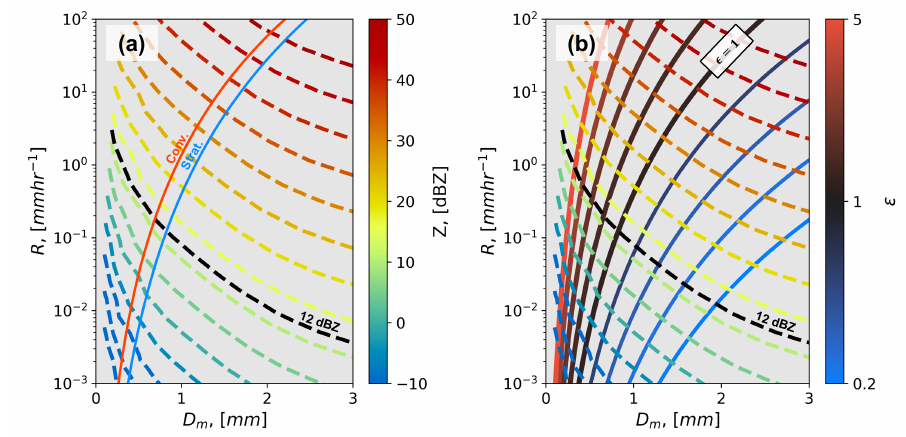
Figure 2. Precipitation rate ( R ) and mass weighted mean diameter ( D m ) theoretical diagrams. ( a ) The default ( (cid:101) = 1) R − D m relation for both convective (solid red line) and stratiform (solid blue line) regimes with the equivalent radar reflectivity factor ( Z e ) in logarithmic units (dBZ) is contoured (dashed rainbow lines) assuming rain. The Z e contours are determined using the same assumptions as those in the GPM-DPR algorithm for a range of (cid:101) values. The dashed black line is the 12 dBZ, contour which is the GPM-DPR Ku-band minimum sensitivity. ( b ) Similar to ( a ), the rainbow contours are the Z e , while the other lines are the stratiform relation, but now the (cid:101) parameter is varied. The default relation ( (cid:101) = 1) is in black, while (cid:101) > 1 is in red shades and (cid:101) < 1 is in blue